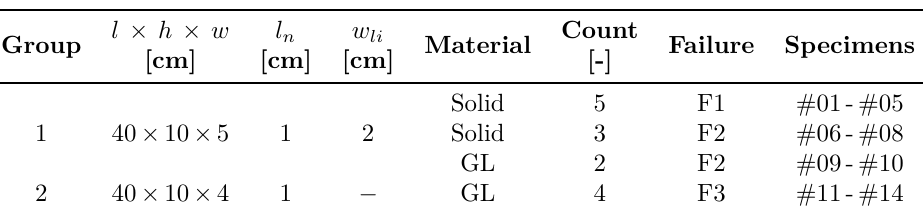
Table 1. Test program characteristics and first failures types (F1 - splinter around the ligament, F2 - splinter around the ligament + shear, F3 - parallel with the grain).